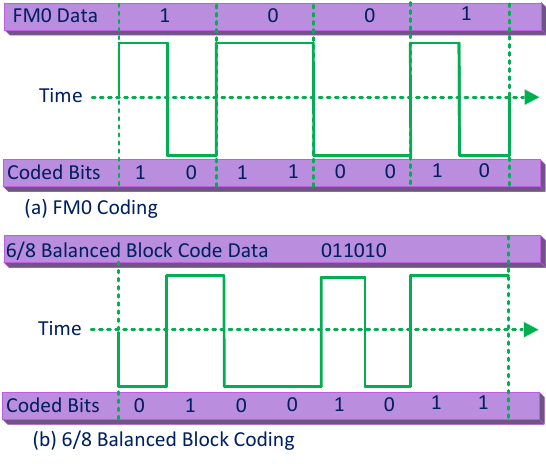
Figure 12. Coding in